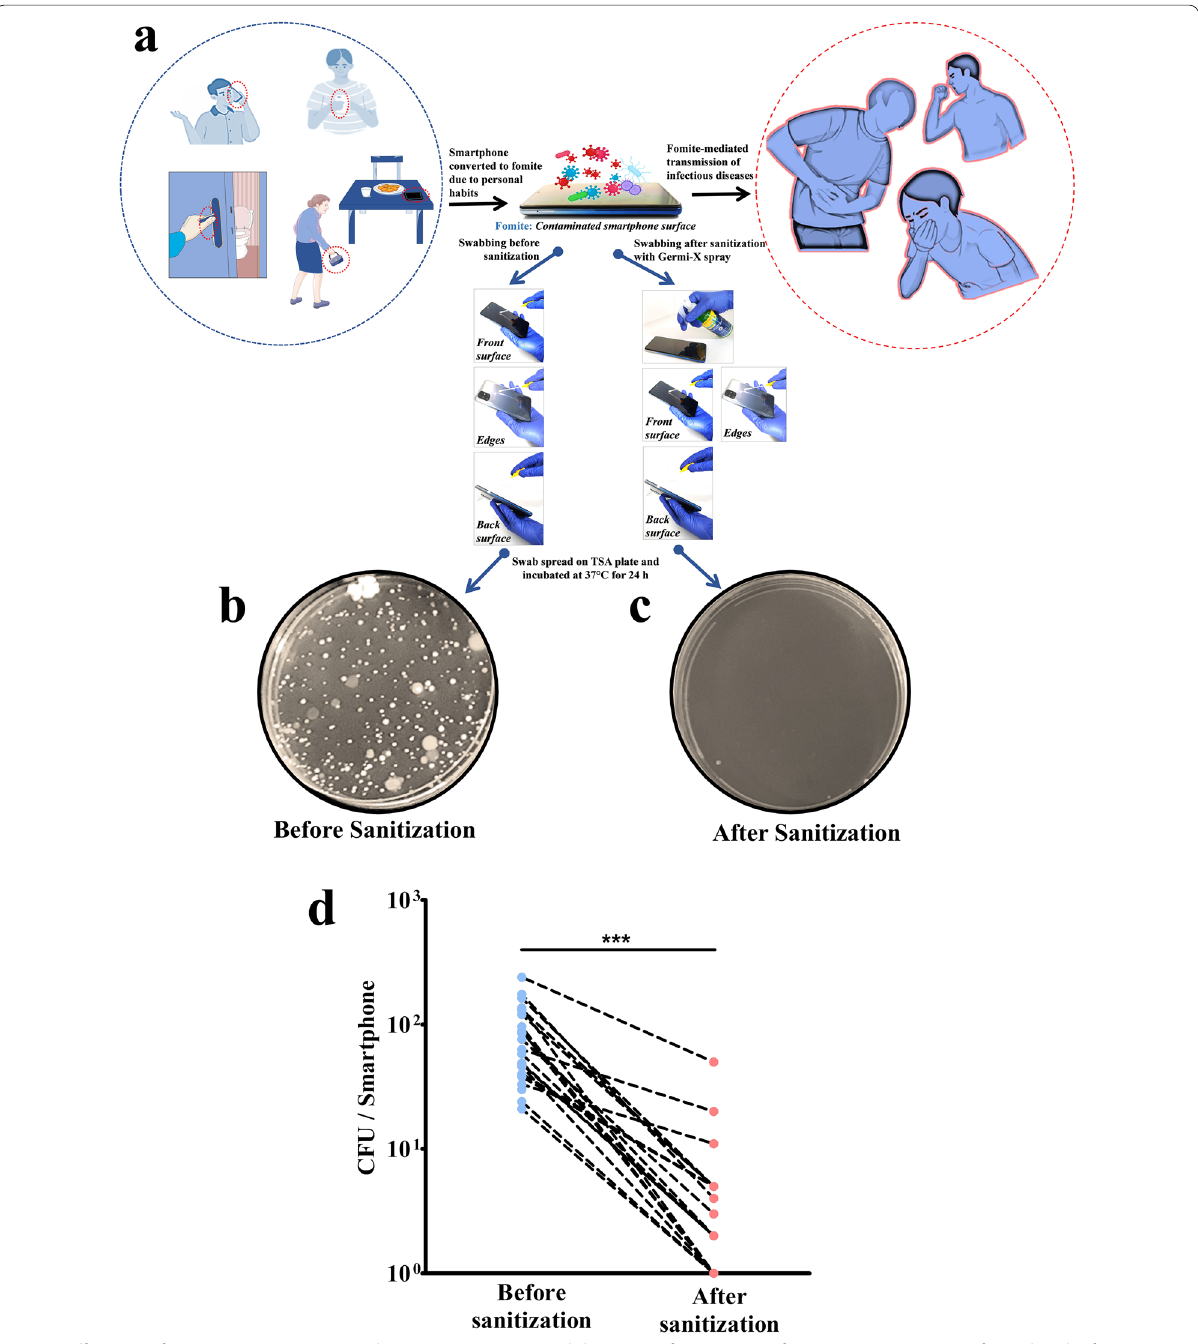
Fig. 5 Effectivity of Germi-X spray as a smartphone sanitizer. a Pictorial depiction of acquisition of germs on inanimate surfaces thereby forming fomites and their subsequent role in transmitting diseases. The illustration also summarizes the experimental steps followed for collecting swab samples from smartphones before and after sanitization with Germi-X spray. b , c Representative digital images of bacteriological plates showing the growth of microflora in the swab sample collected from smartphones before sanitization with Germi-X spray ( b ) and its lack thereof after sanitization ( c ). d Paired line graphs depicting the reduction in germ load after sanitization of smartphones with Germi-X spray. The statistical significance between the average CFUs in the two groups is determined through Students’s t-test and indicated as ***p <